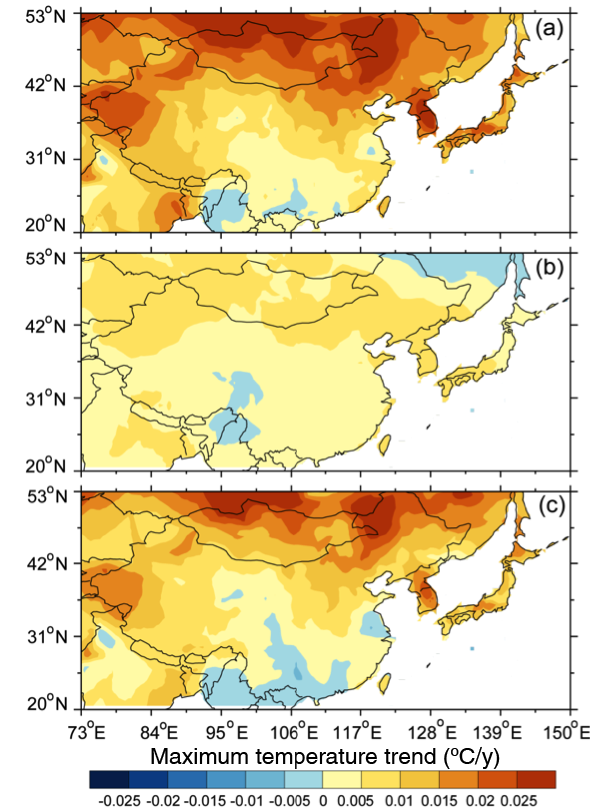
Figure 8. Same as Fig. 3, except for daily maximum temperatures.